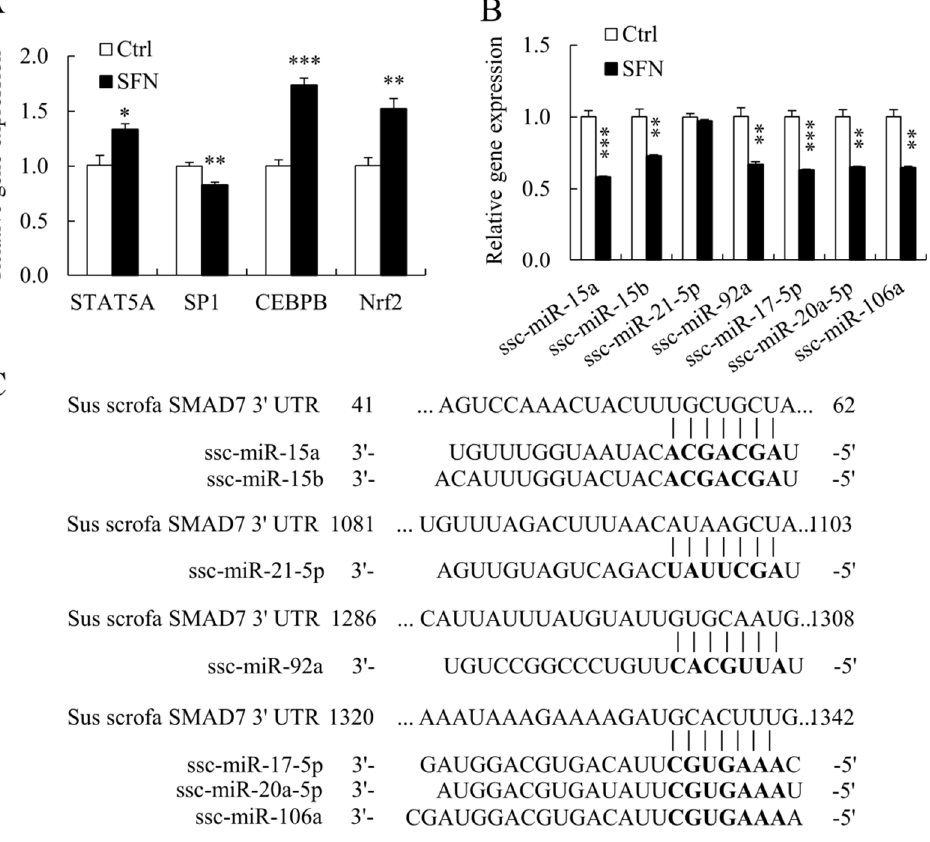
Figure 5. TFs and miRNAs regulating SMAD7 were remodeled by SFN treatment. ( A ): Relative mRNA expression levels of porcine SMAD7 TFs; ( B ): Relative expression levels of porcine miRNAs targeting SMAD7 ; ( C ): The alignments of porcine miRNAs and corresponding binding sites in SMAD7 3’ UTR. Data are shown as the mean ± SE and assays were done in triplicates. * p < 0.05, ** p < 0.01, *** p < 0.001.